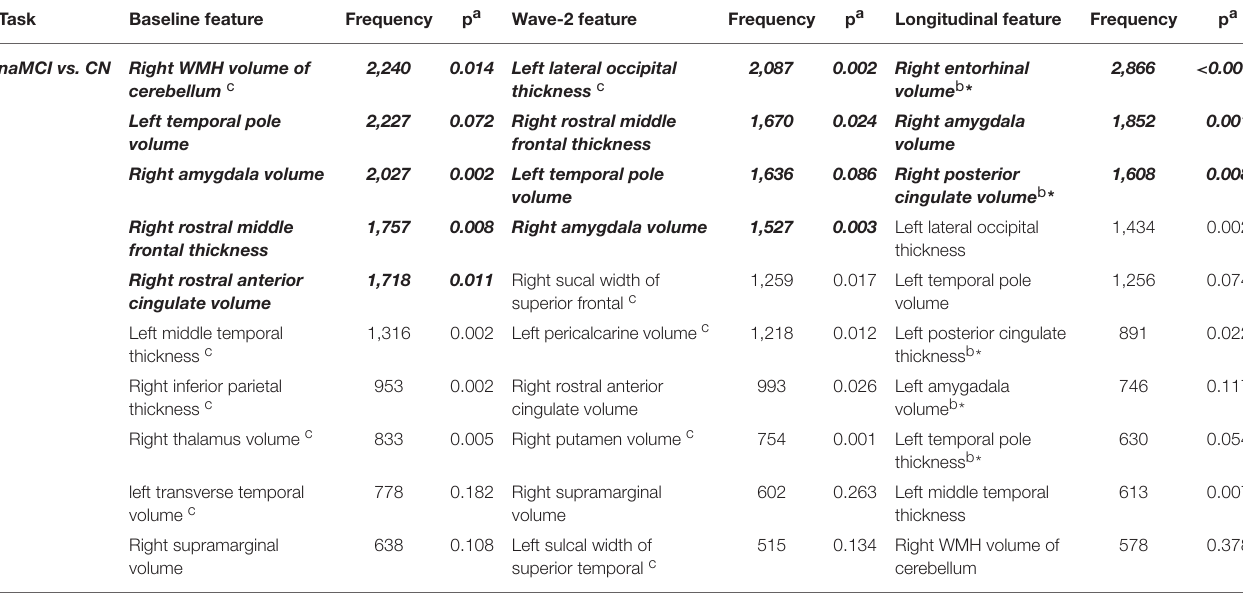
TABLE 4 | Selected features for the classification of naMCI vs.